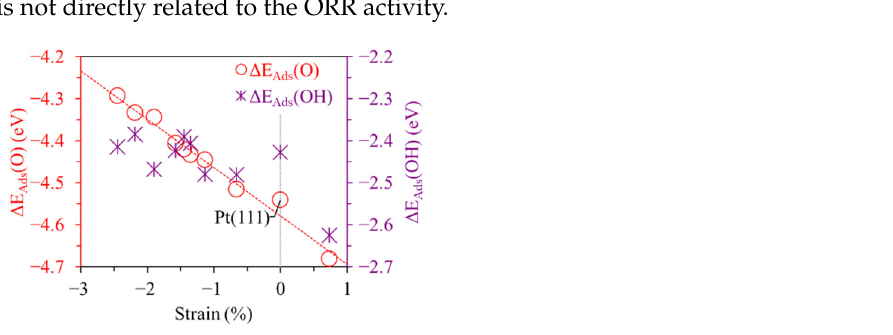
Figure 3. Relation between OER/ORR overpotential and adsorption energy of reaction intermedi- ates O ( a ) and OH ( b ). A smaller negative value on the x -axis (to the right) indicates weaker adsorp- tion.